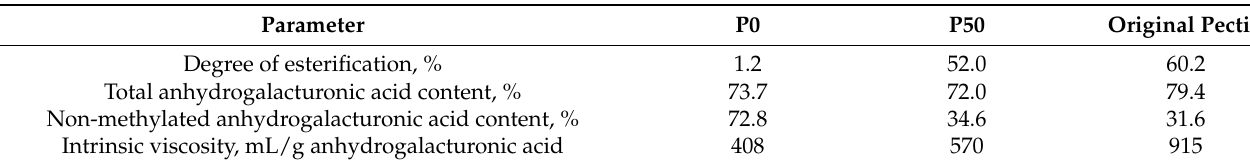
Table 1. Physicochemical parameters of pectin preparations.